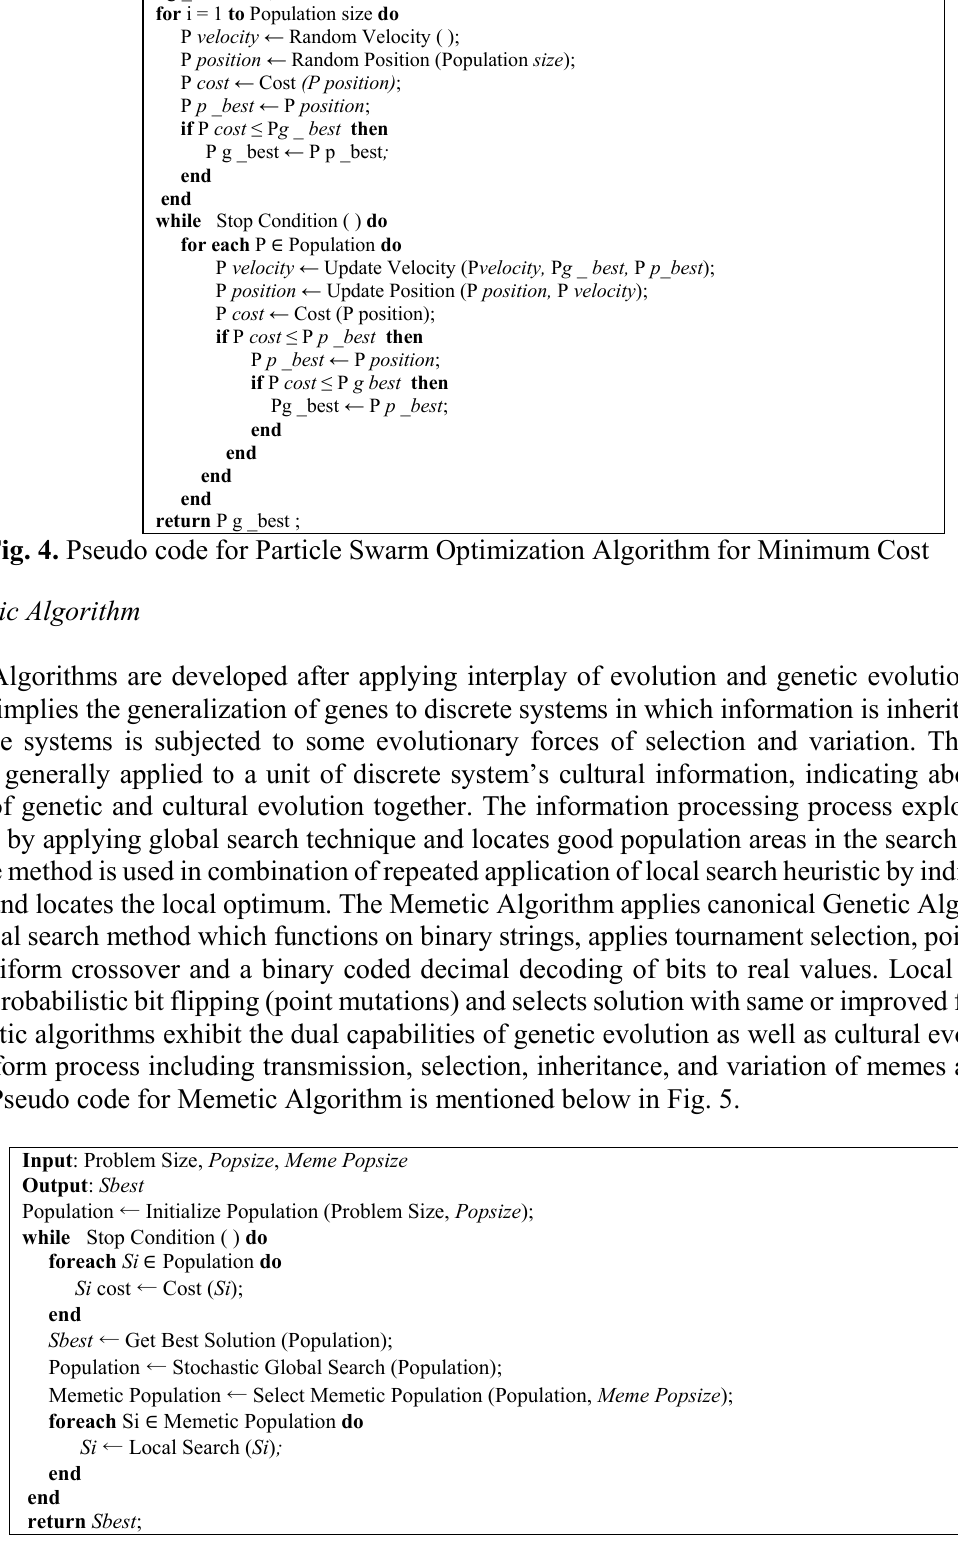
Fig. 5. Pseudocode for Memetic